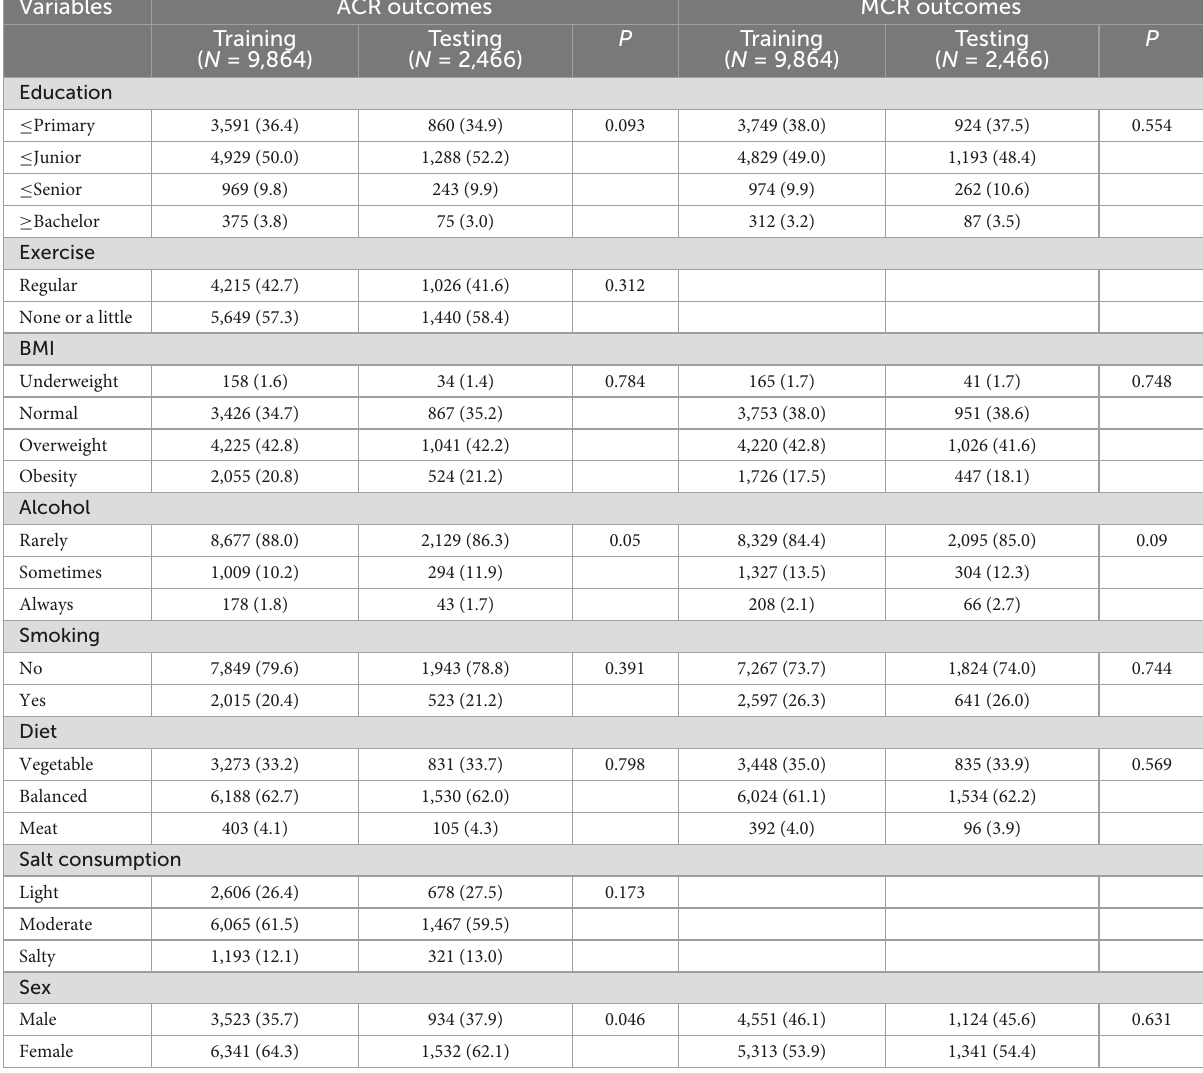
TABLE 3 Comparisons of qualitative clinical indexes between training set and testing